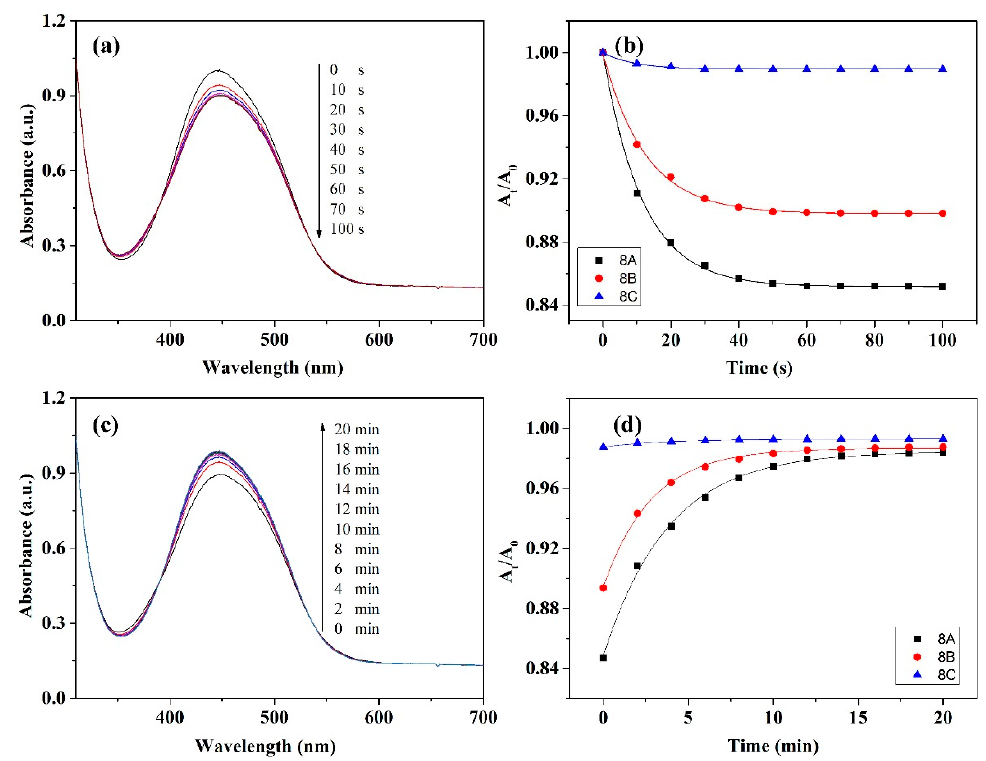
Figure 5. UV-vis spectra of spin-coated film of 8B irradiated with 450 nm light ( a ) and in the dark after reaching photo-stationary state ( c ); relative absorbance at λ max and the corresponding fitted curves for spin-coated film of 8A , 8B , and 8C during the trans - cis ( b ) and cis - trans ( d ) isomerization.